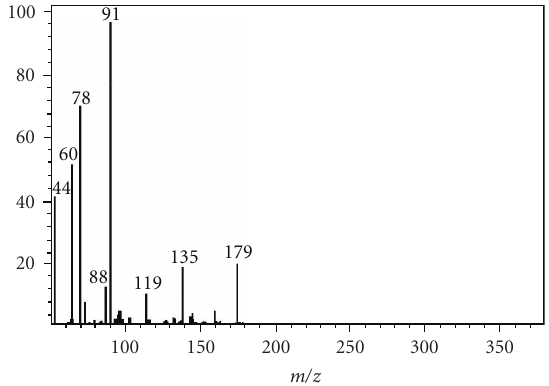
Figure 2: Suggested structure of complex, where M = Zn(II) and Hg(II) and X = Cl − , NO 3 − and 1/2SO 42 − . Figure 3: Electronic impact mass spectra of ligand (L).